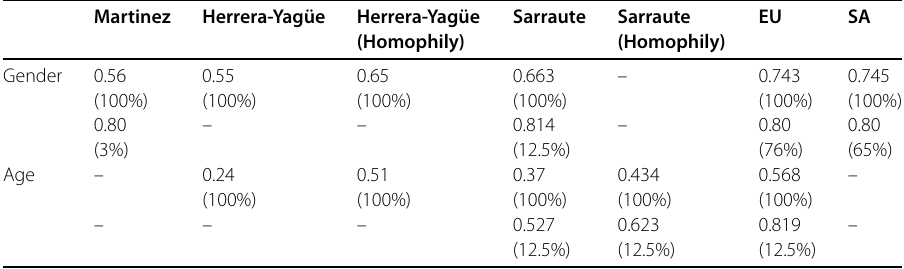
Table 6 Comparison of our framework with the most related work